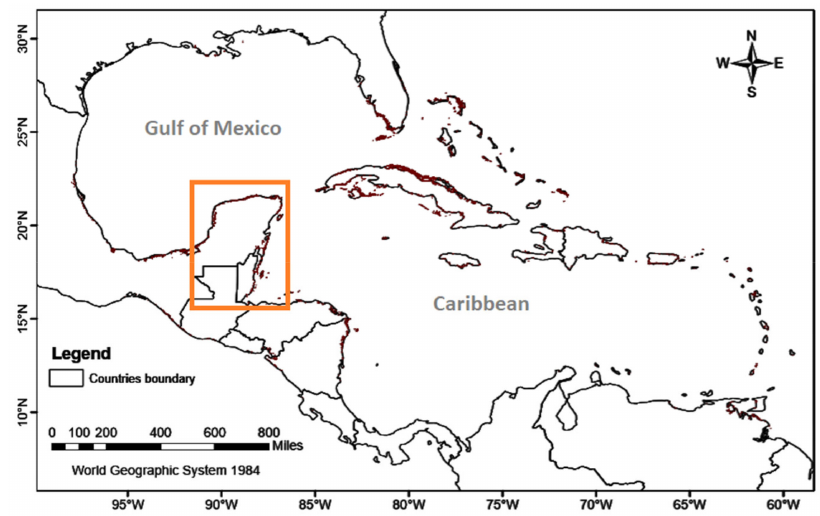
Figure 1. The Mexican Caribbean, which includes the Yucatan Peninsula, is highly affected by hurricanes and is representative of the rest of the Caribbean in terms of risk reduction needs and policies that include